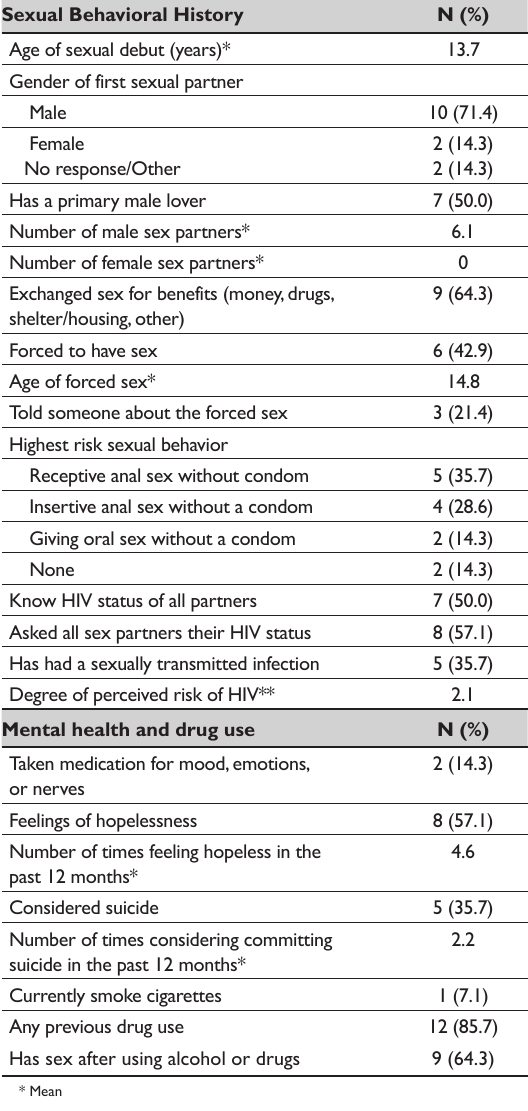
Table 2: Frequency of condom usage among participating HBC leaders